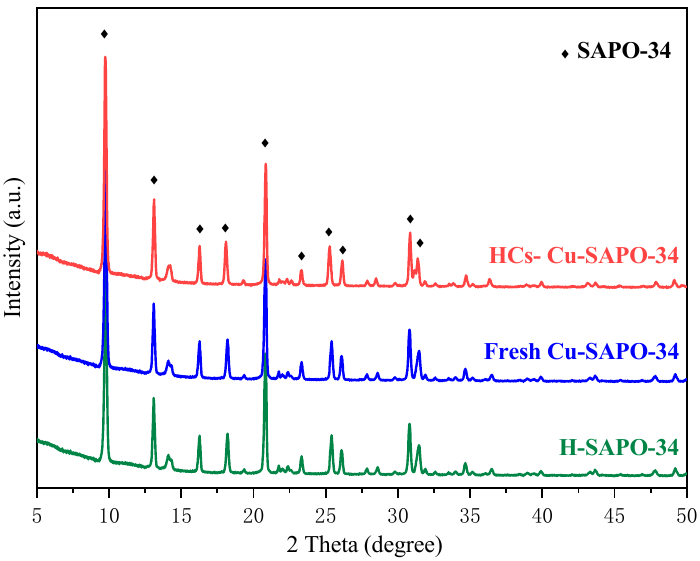
Figure 1. XRD patterns of H-SAPO-34, fresh Cu-SAPO-34, and HCs-Cu-SAPO-34. Table 1. Comparison of BET surface area results of fresh Cu-SAPO-34 and HCs-Cu-SAPO-34.